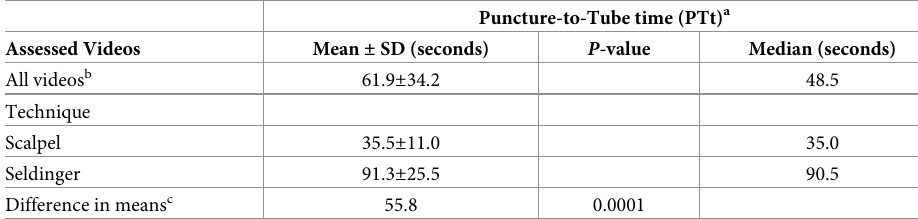
Table 1. Puncture-to-Tube time stratified by cricothyrotomy technique.